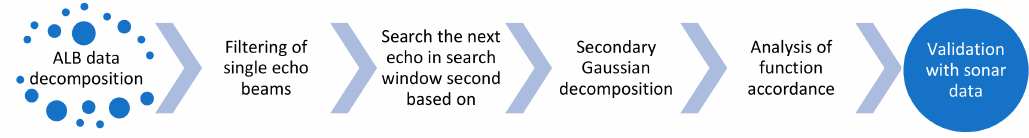
Figure 2. Workflow of the